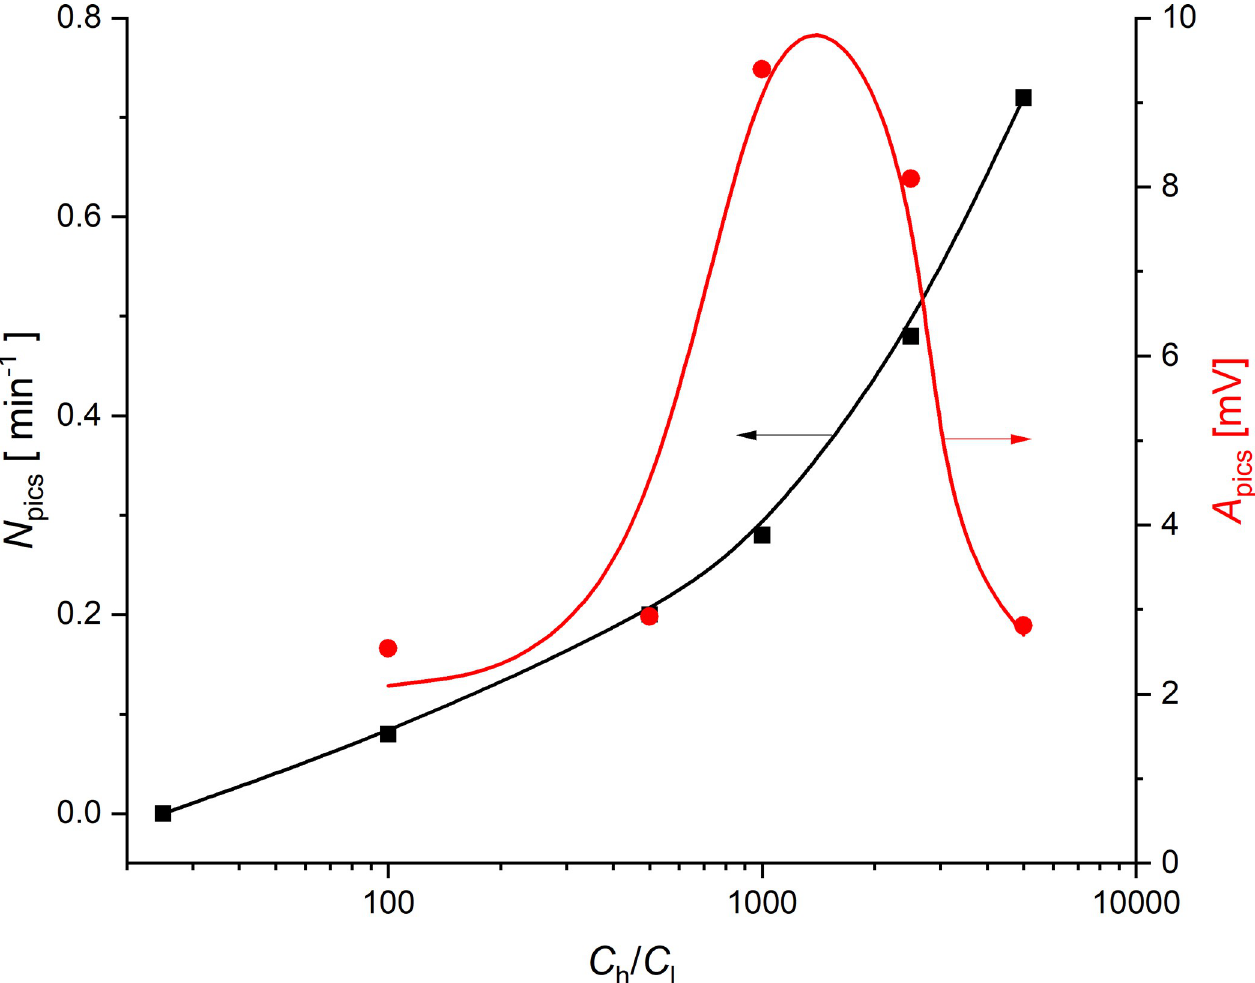
Fig 7. Frequency of the number of peaks ( N pics ) (black, left vertical axis) and average amplitude of pics ( A pics ) (red, right vertical axis) observed in the range of time from 50min to 100min as a function of the quotient of the concentrations on the membrane ( C h / C l ) at the initial